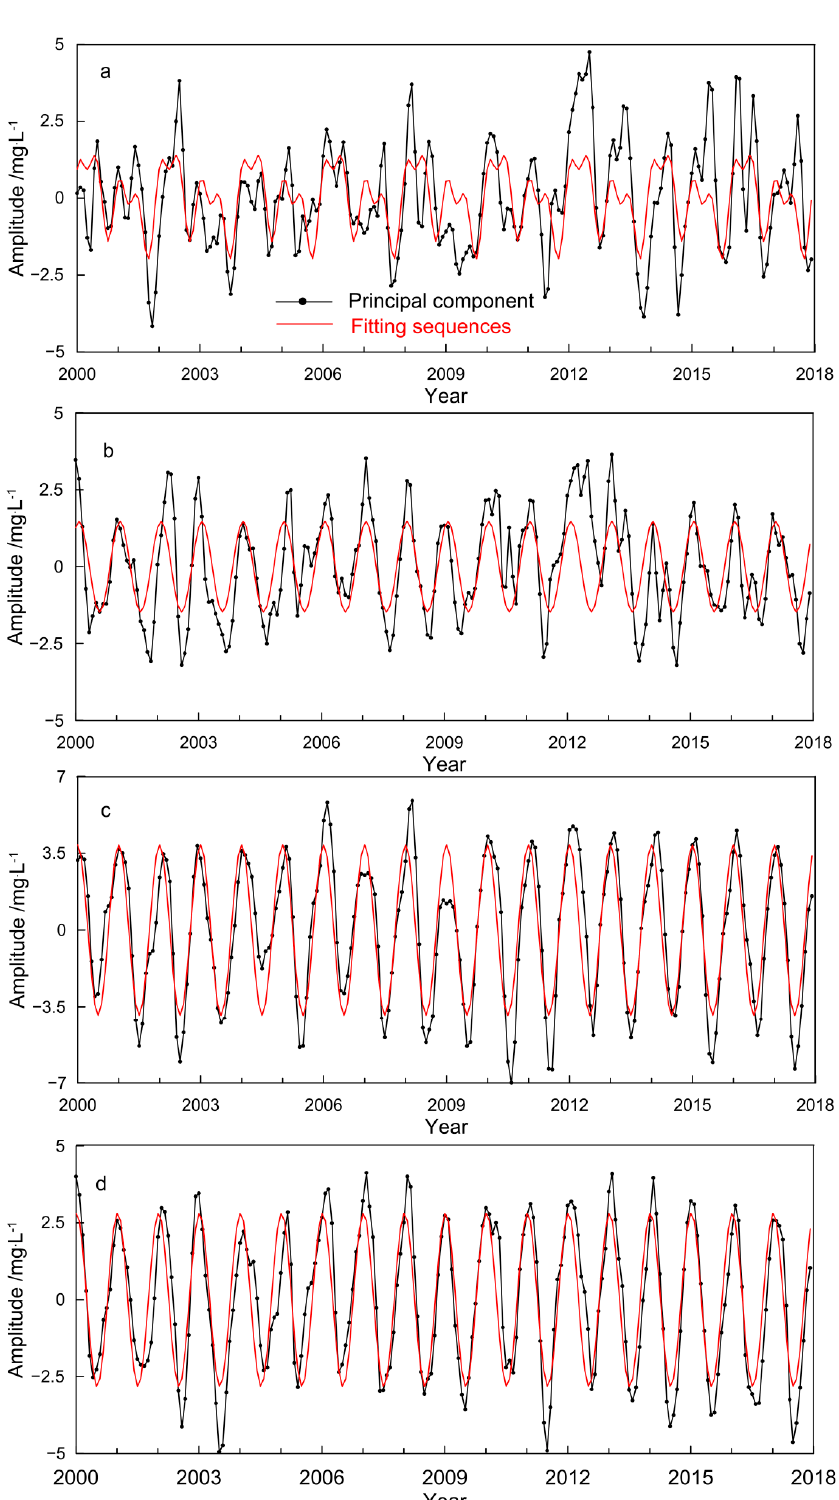
Figure 7. RPCs of DO and their fitted values. ( a ) RPC1 at surface; ( b ) RPC2 at surface; ( c ) RPC1 at bottom; ( d ) RPC2 at bottom.